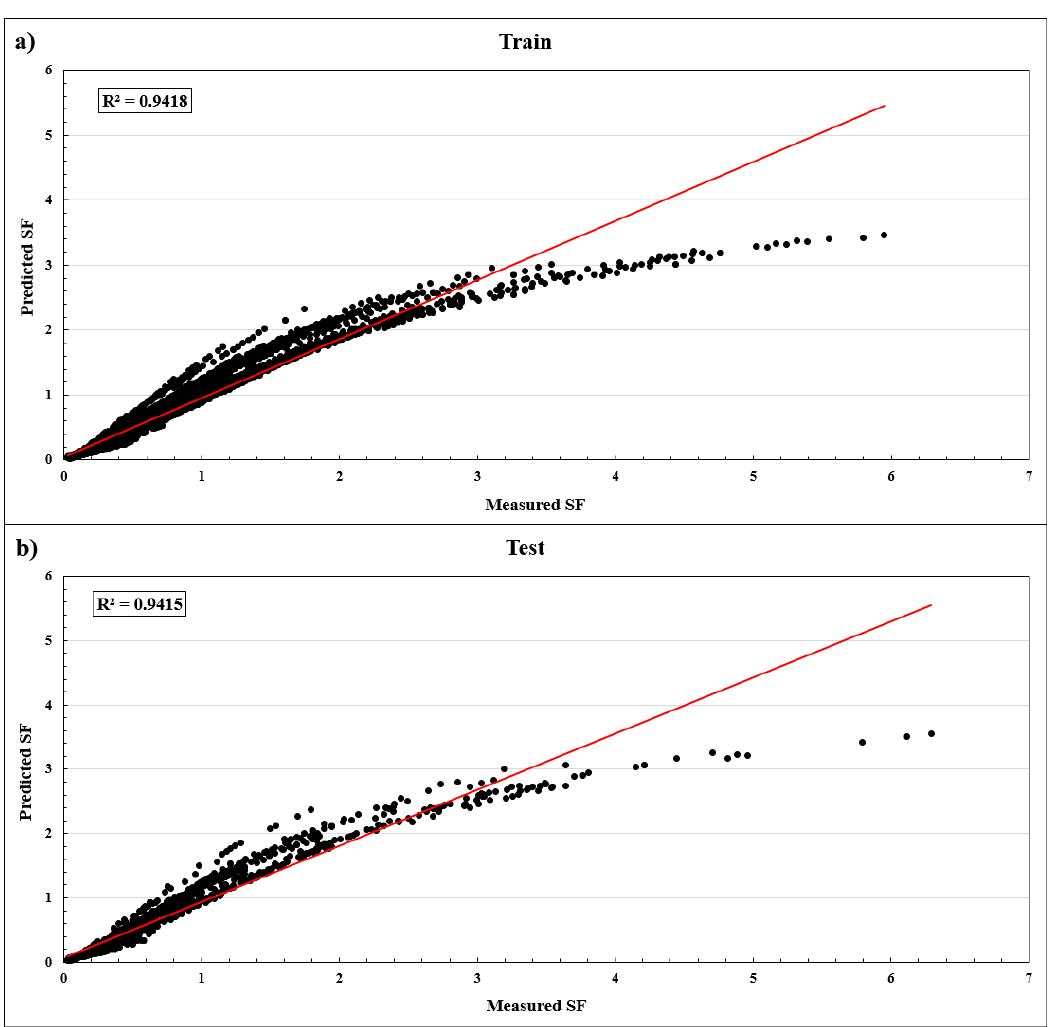
Figure 13. Results of the best predictive model (GA-ANN) in estimating SF values of RWs ( a ) Train, ( b ) Test.